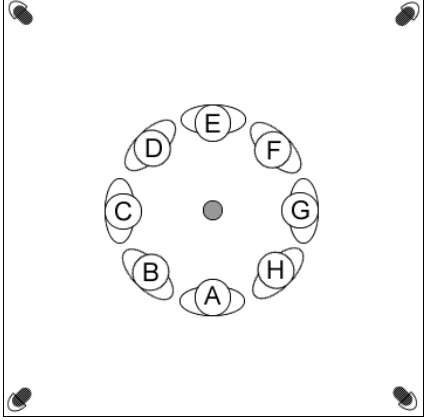
Figure 6. Locations where user stands around each check point. Grey circle in centre indicates check point, over which the smartphone is held. The 8 silhouettes marked A–H show a top view of the user standing with their back facing outwards in all